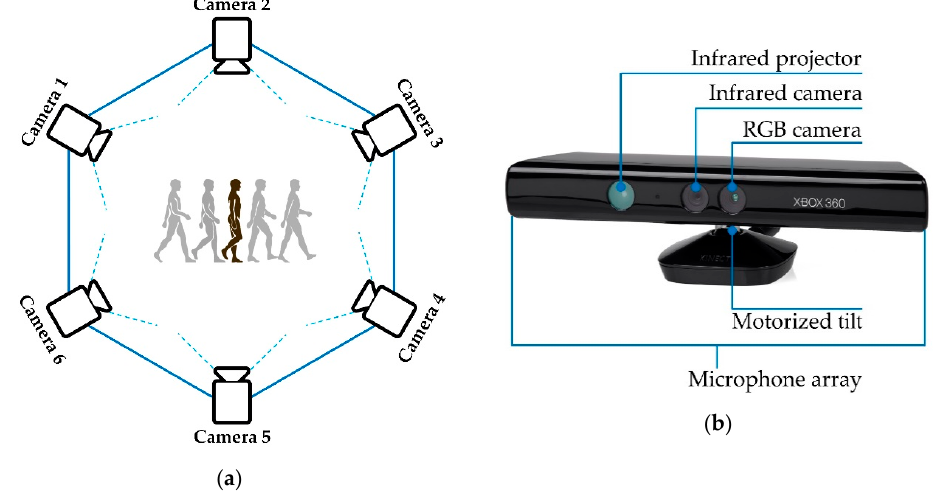
Figure 9. ( a ) Distributed camera networks for skeletal tracking; ( b ) Microsoft Kinect sensor system.